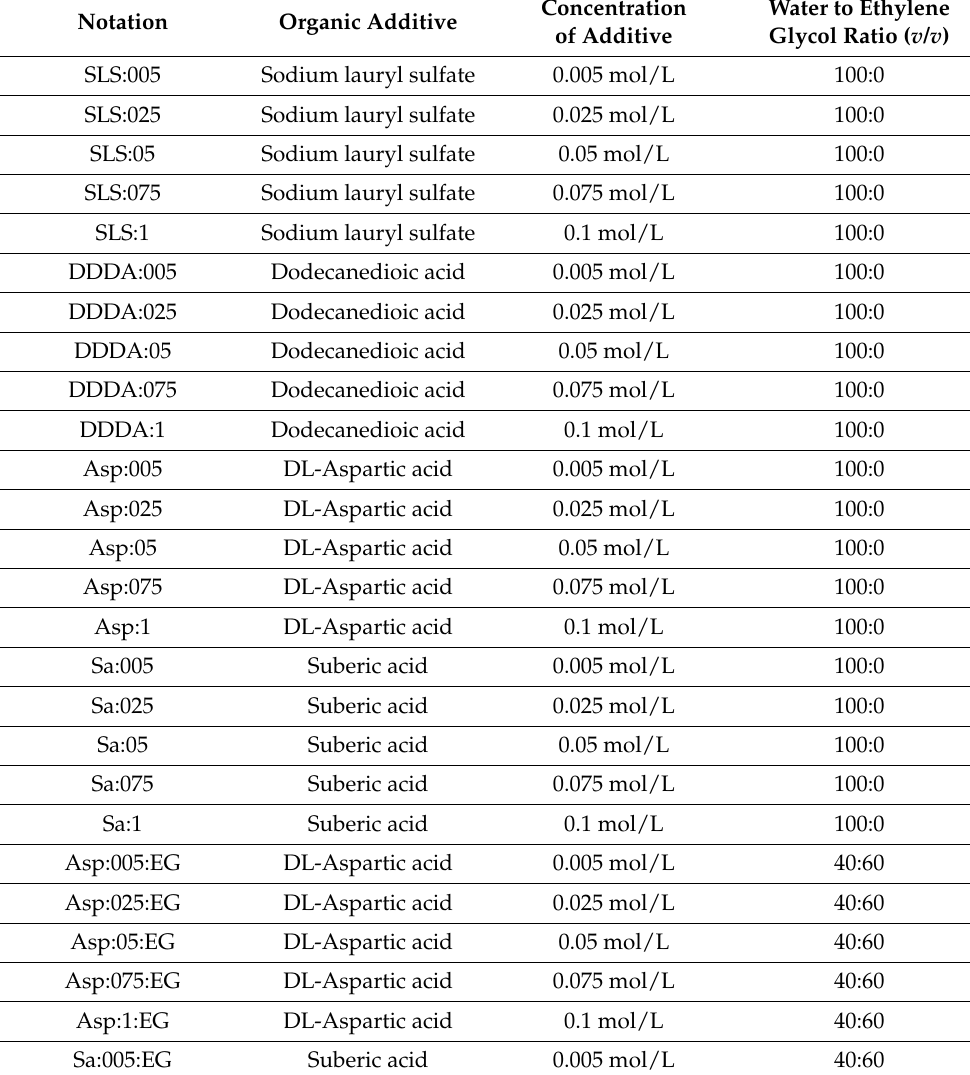
Table 1. Sample codes, used organic additive, concentration of additives, and reaction media.